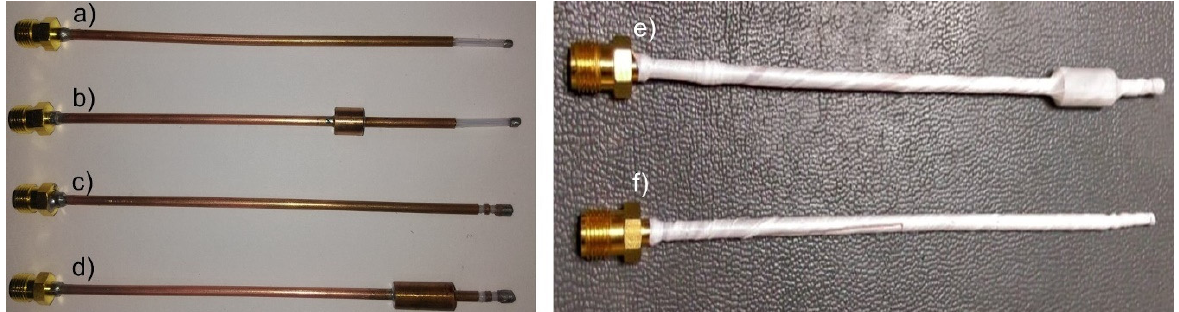
Figure 5. Micro-coaxial antennas. ( a ) Metal-Tip Monopole antenna, ( b ) Chocked Metal-Tip Monopole antenna, ( c ) Double Slot antenna, ( d ) Chocked Double Slot antenna, ( e ) Chocked Double Slot antenna tested in porcine ex vivo tissue and ( f ) Metal-Tip Monopole antenna tested in porcine ex vivo tissue.